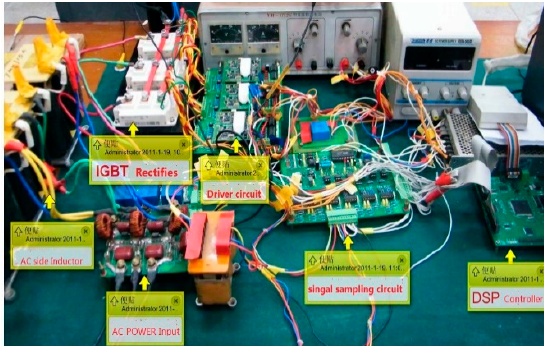
Figure 18. The hardware prototype Figure 18. the hardware prototype system. Figure 18. the hardware prototype system.